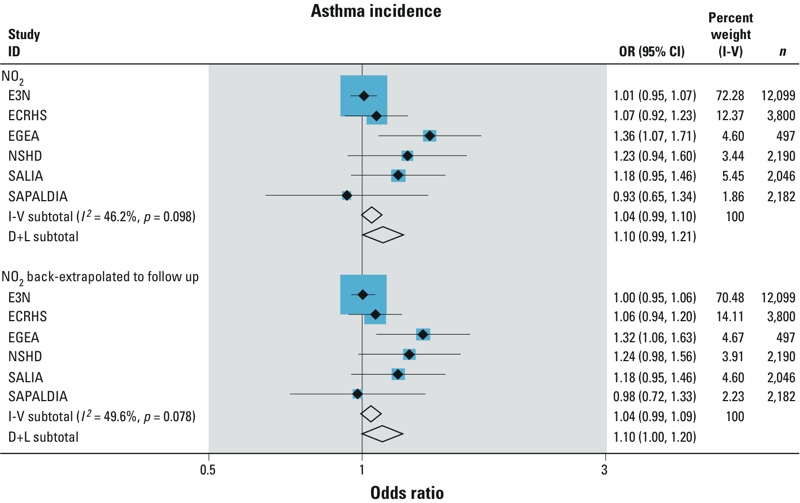
Associations of NO2 and NO2 back-extrapolated (per 10 μg/m3) on asthma incidence. Meta-analysis from the study-specific adjusted random-effects logistic regression models. The logistic regression models were adjusted for age, sex, smoking, overweight, and education level (model 3) with random effects per city/area for each study except for SALIA, where there is only one area, and EGEA, where family structure was taken into account. I-V: inverse variance weighted (fixed effect) pooled estimate of all studies. I2: variation in estimate effect attributable to heterogeneity. D+L: DerSimonian and Laird (random effect) pooled estimate of all studies. Study-specific odds ratios are shown as solid black diamonds with horizontal lines representing 95% CIs. The size of the blue squares reflects the statistical weight of the study in the meta-analyses. The meta-analytic odds ratios are shown as open black diamonds, the middle of the diamond corresponds to the odds ratio value, and the width of the diamond represents the 95% CI.